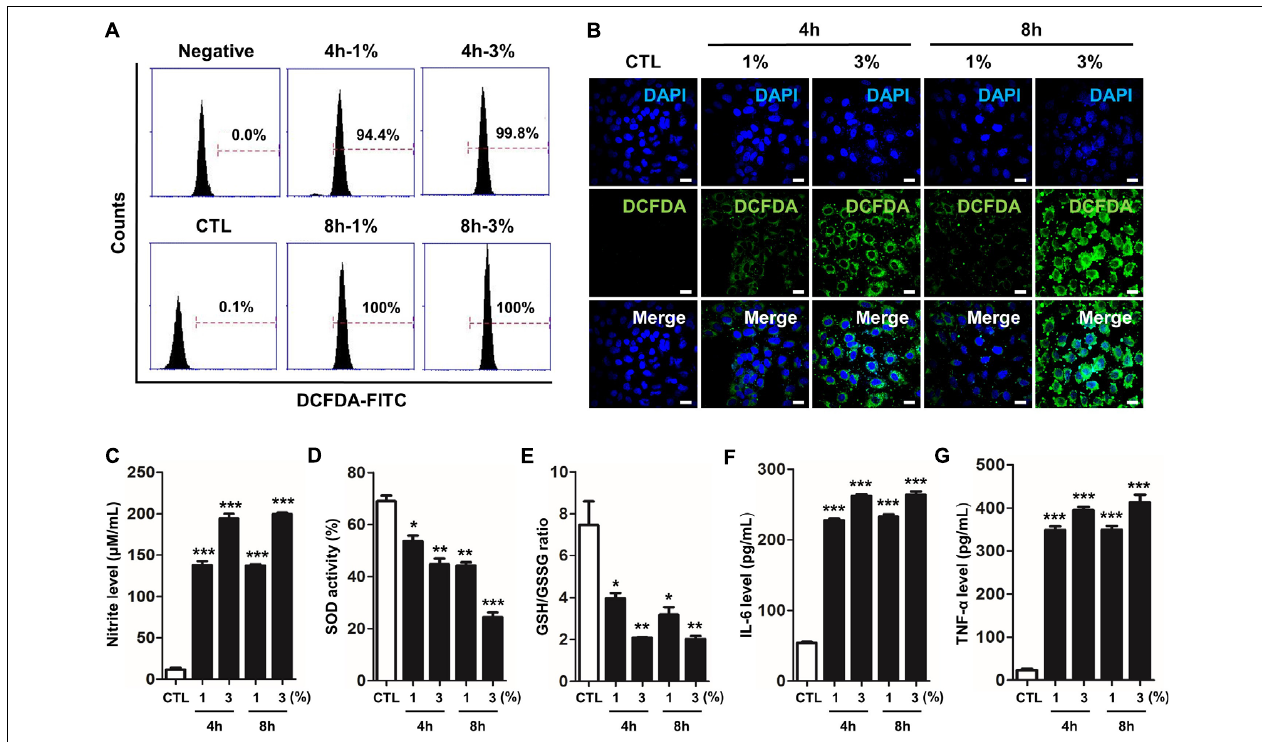
FIGURE 1 | CSE-induced intracellular RONS stress and inflammation in human alveolar epithelial cells. The A549 epithelial cells were incubated in the presence (1–3%) or absence of CSE for 8 h, followed by a measurement of the intracellular redox states. (A) The fixed quantity of oxidized DCF-DA probe was evaluated by flow cytometry. The x -axis indicate the intensity of intracellular DCF-DA fluorescence, and the y -axis represent the mean number of live cells. (B) The cells exposed to CSE were loaded with DCF-DA for 30 min before being imaged using confocal laser scanning microscopy. A amount of DCF-DA is linked to live cells damaged by ROS. (C) The concentration of nitrite released into the culture medium was determined using the Griess assay 4 h or 8 h after CSE exposure. (D) Total SOD activity was measured in cell lysate exposed to CSE. (E) The ratio of glutathione (GSH)/oxidized glutathione (GSSG) was detected at different reaction time using a colorimetric assay at OD 412nm . The calculated the total GSH and GSSG level of test samples based on the standard curve of (cid:77) OD 412nm /min verses GSH or GSSG standard solutions. A decreased ratio of GSH-to-GSSG is an indication of oxidative stress. The level of (F) IL-6 and (G) TNF- α were determined by ELISA in culture supernatants. The results are represented by average value of data ( ± SE). CTL, no treatment. ∗ p < 0.05, ∗∗ p < 0.01, and ∗∗∗ p < 0.001 vs.